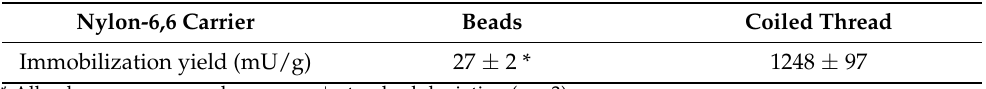
Table 4. Pectinase immobilization yield on different nylon 6/6 carriers.